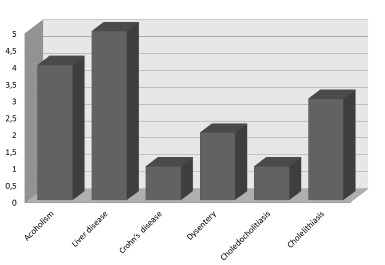
More frequent associated conditions